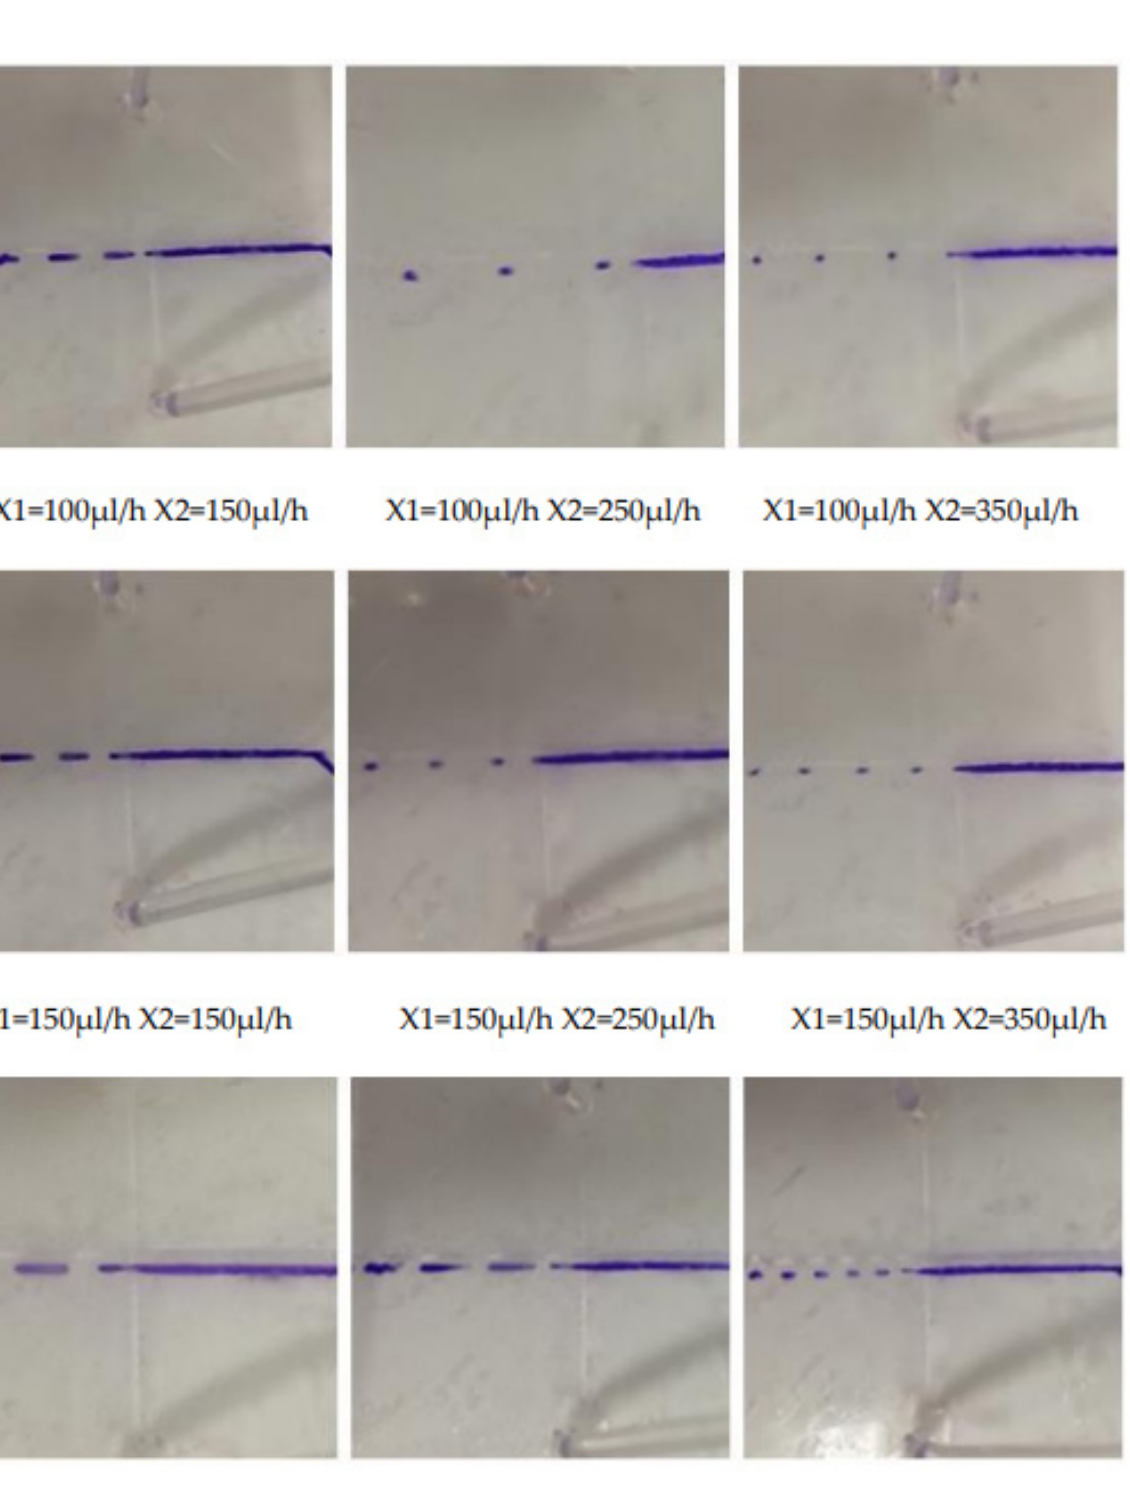
Figure 10. The experimental results of flow rate of the dispersed phase being constant and the flow rate of the continuous phase changing